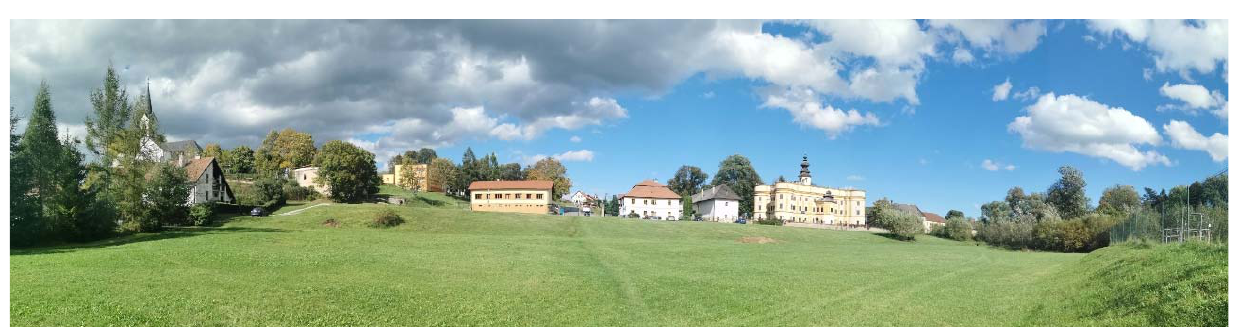
Table 1. Values of the location.